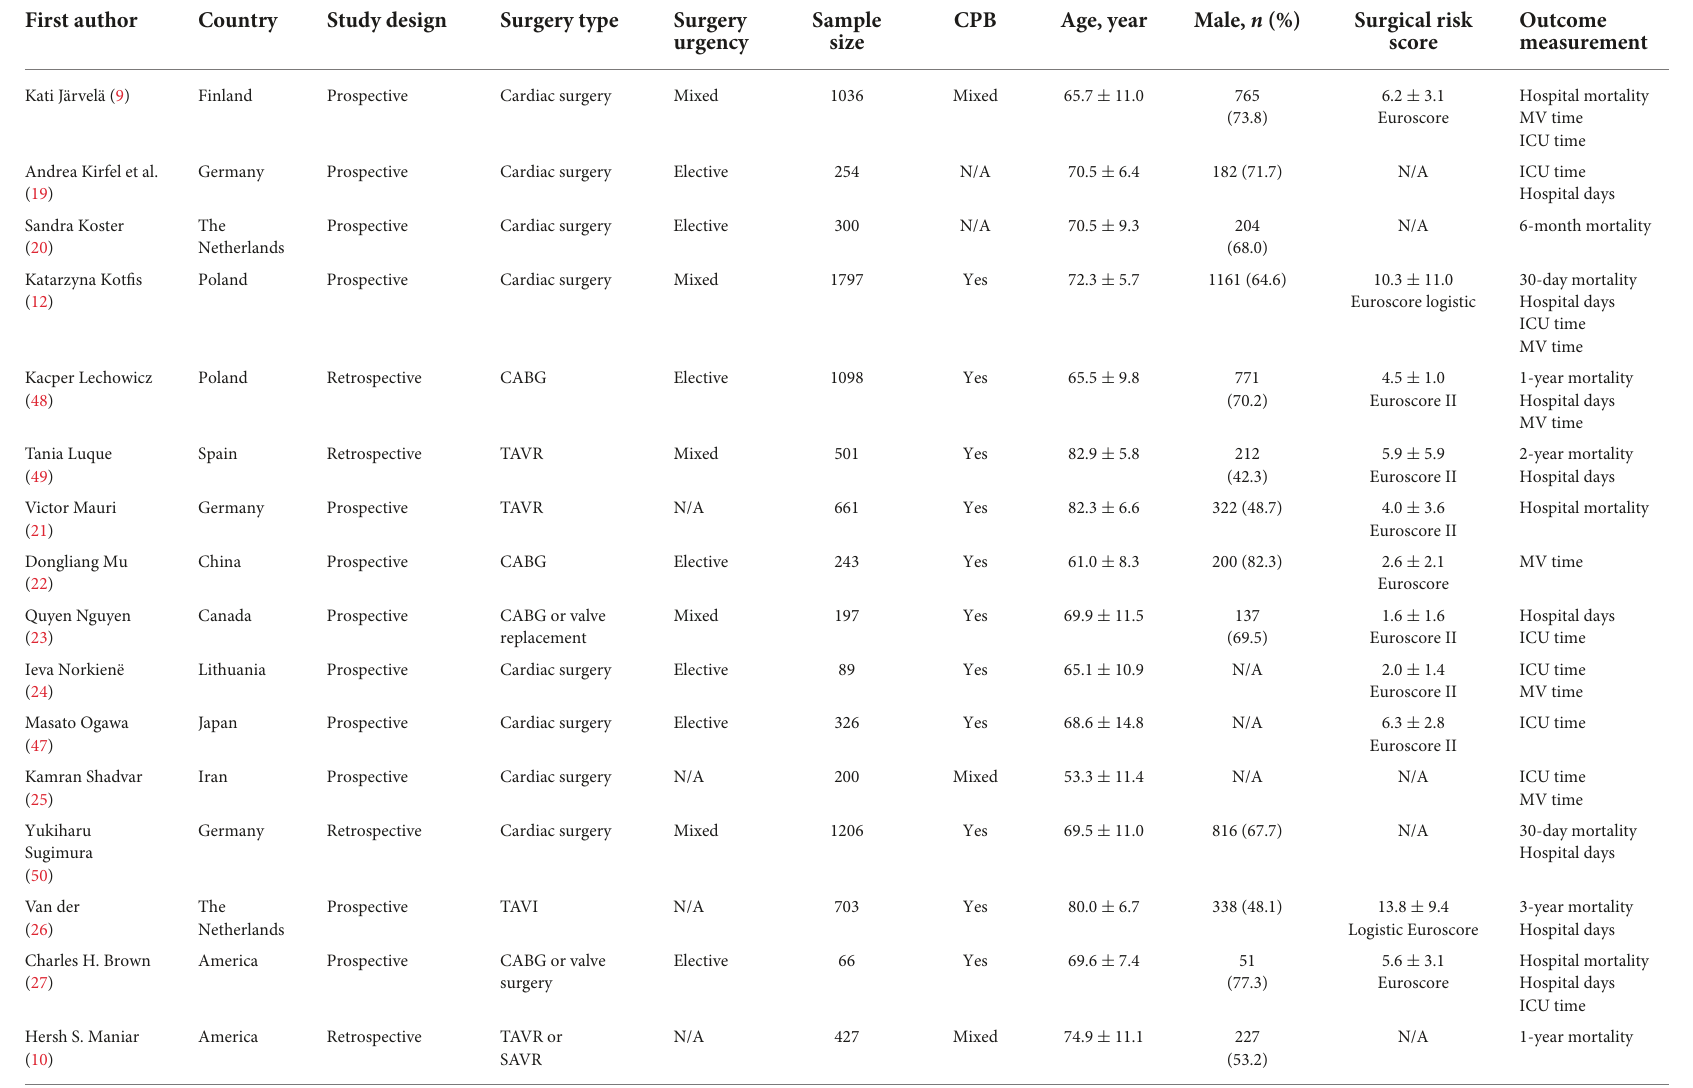
TABLE 1 Characteristics of the included